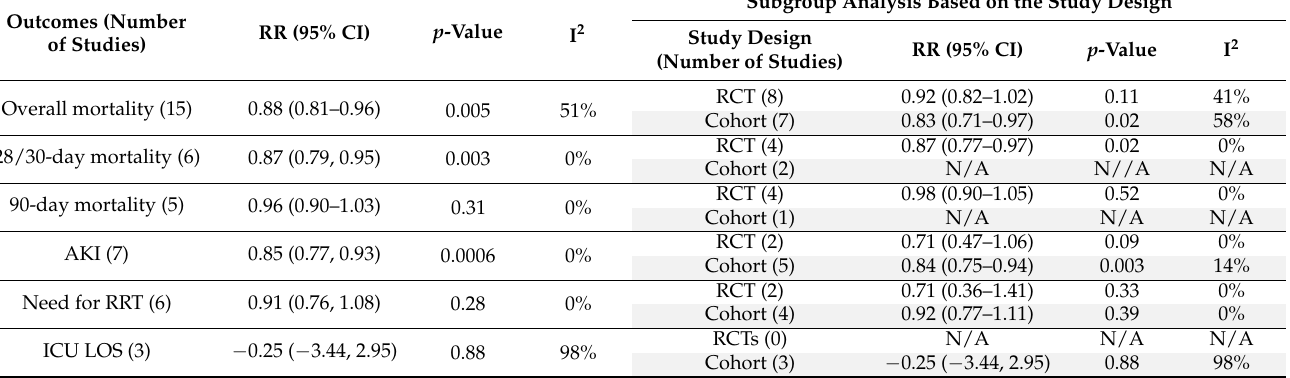
Table 3. Detailed analysis of the outcomes of the meta-analysis with subgroup analysis based on the study